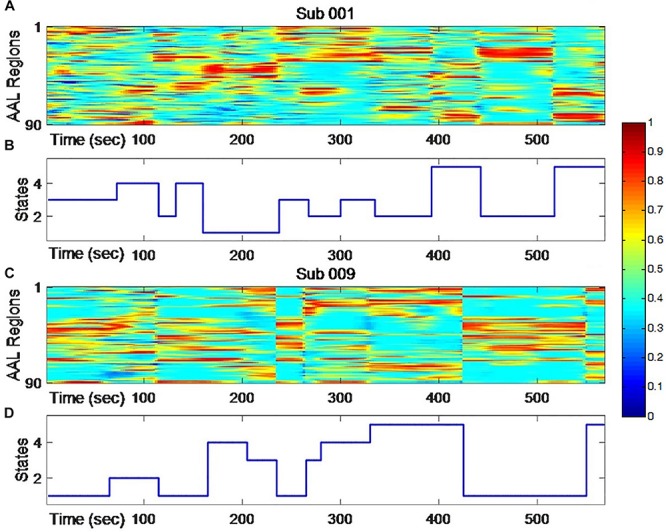
The dynamic changing of node centrality (A,C) and changing states of clustering analysis (B,D) for two typical subjects. The color represents normalized node centrality score and red means higher centrality.